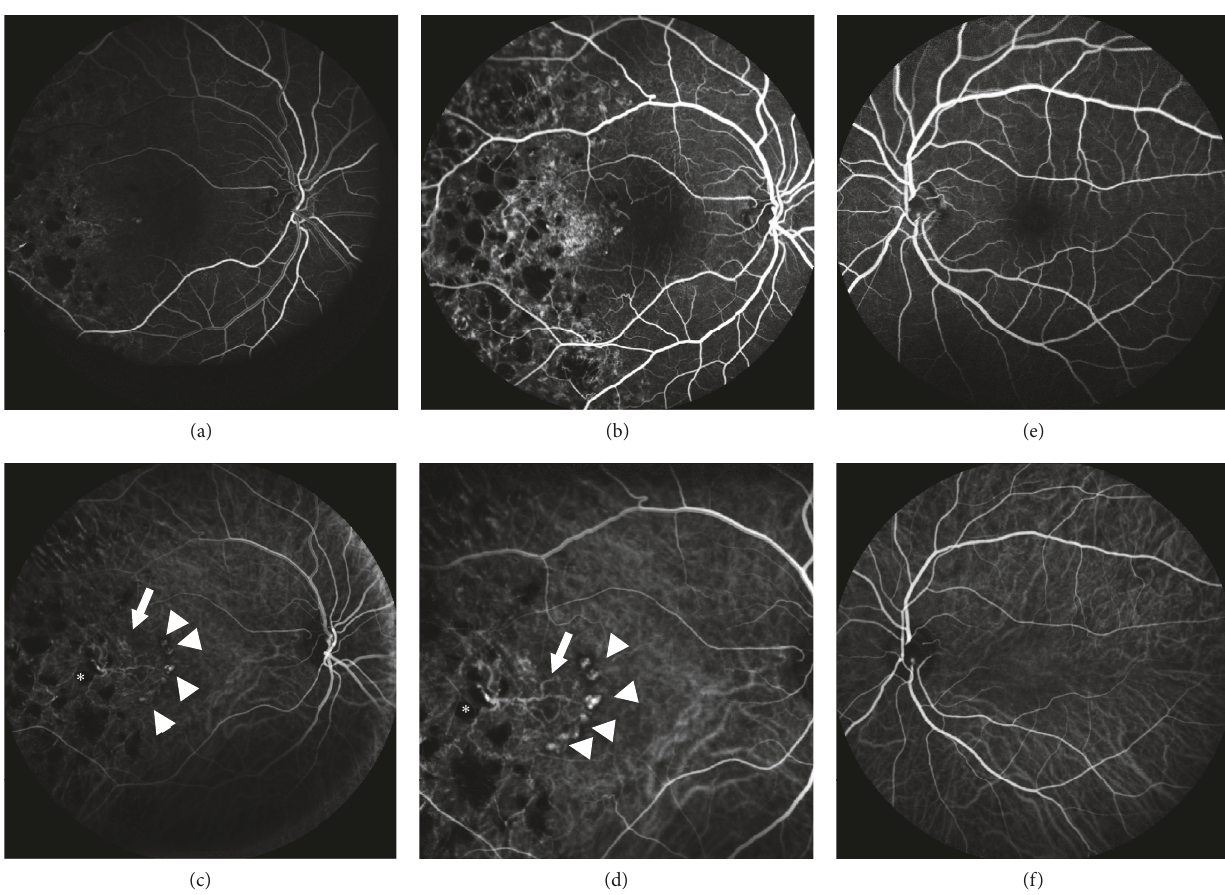
Figure 3: Fundus fluorescein angiogram (55 ∘ ) of right eye (a, b) and left eye (e). Indocyanine green angiography (ICGA) of right eye (55 ∘ c, 30 ∘ d) and left eye (f). The branching vascular network (BVN, white arrows) and terminal hyperfluorescent polyps (white arrowheads) were clearly visible on ICGA. These also demonstrated a characteristichypofluorescent halo. Note that the BVN originates from a hypofluorescent laser scar ( ∗ in c and d). FFA of the right eye revealed macular ischaemia. FFA and ICGA of the left eye were normal.